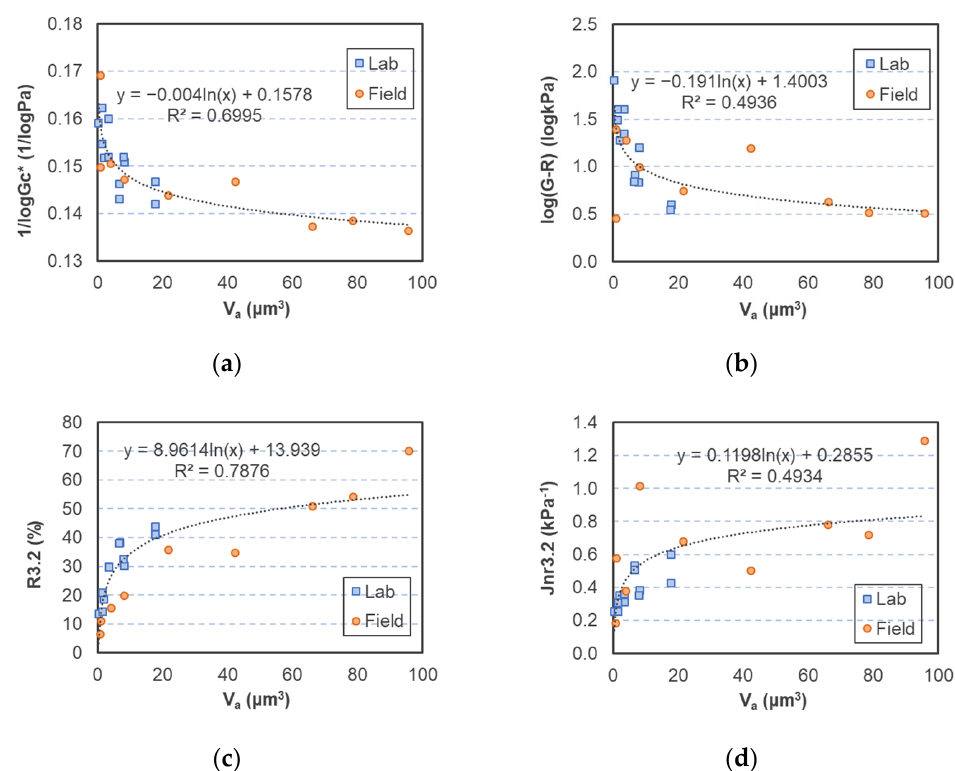
); ( b ) log(G–R); ( c ) R3.2; c